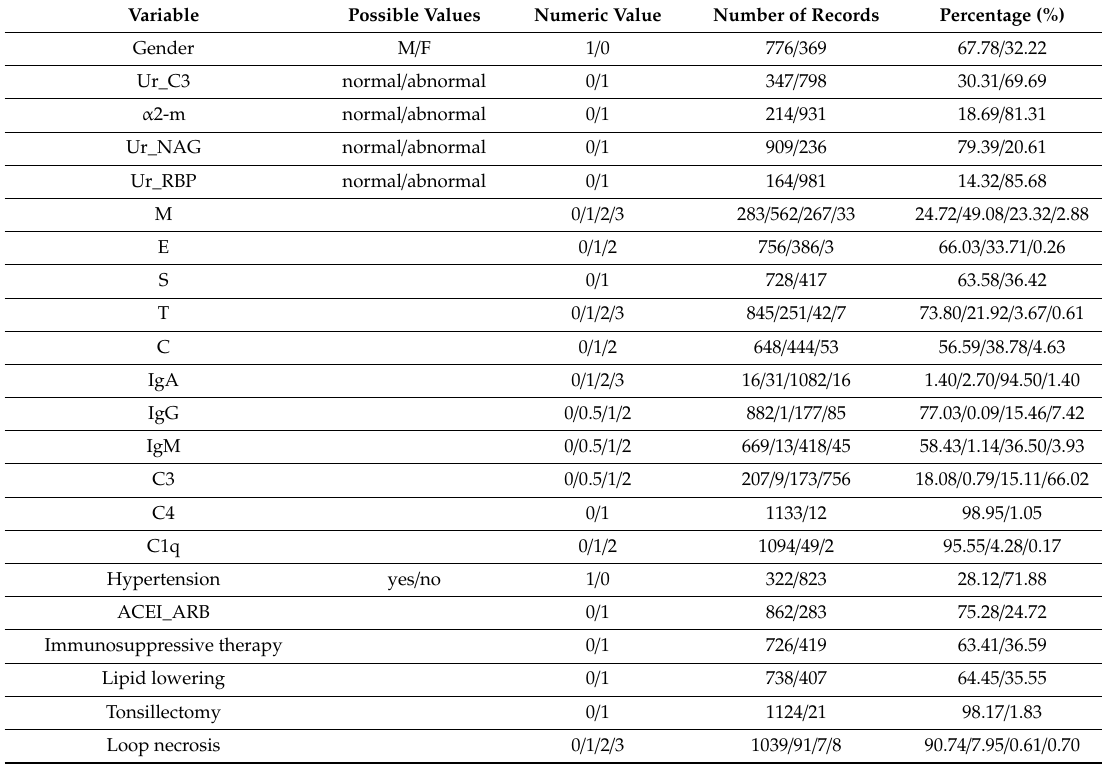
Table 2. Categorical independent